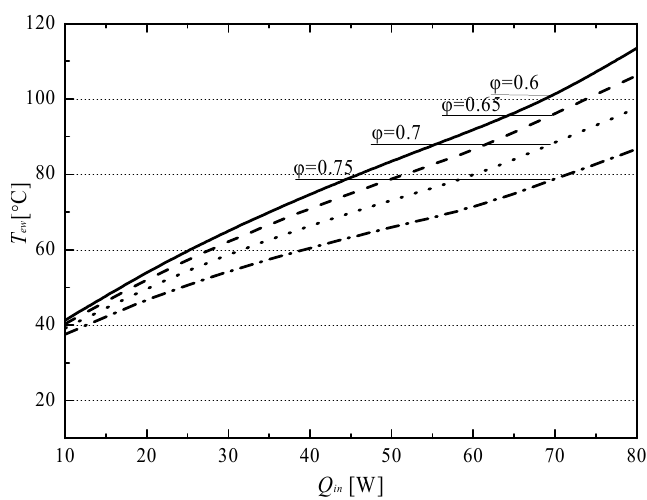
Figure 9. Variations in T ew with input thermal load for different porosities.